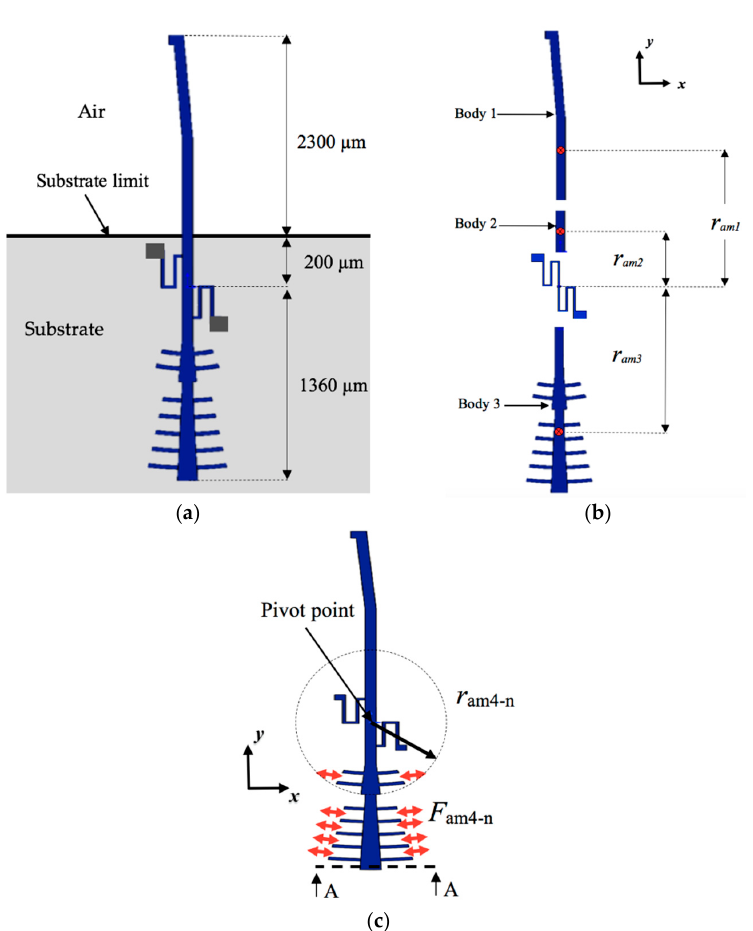
Figure 9. Schematic diagram of the mobile arm considered to calculate the air damping forces: ( a ) dimensions of the three main sections; ( b ) distances of the three first damping force vectors ( F am 1 , F am 2 and F am 3 ) respect to the pivot point; and ( c ) distance of the fourth damping force ( F am 4 ) respect to the pivot point.